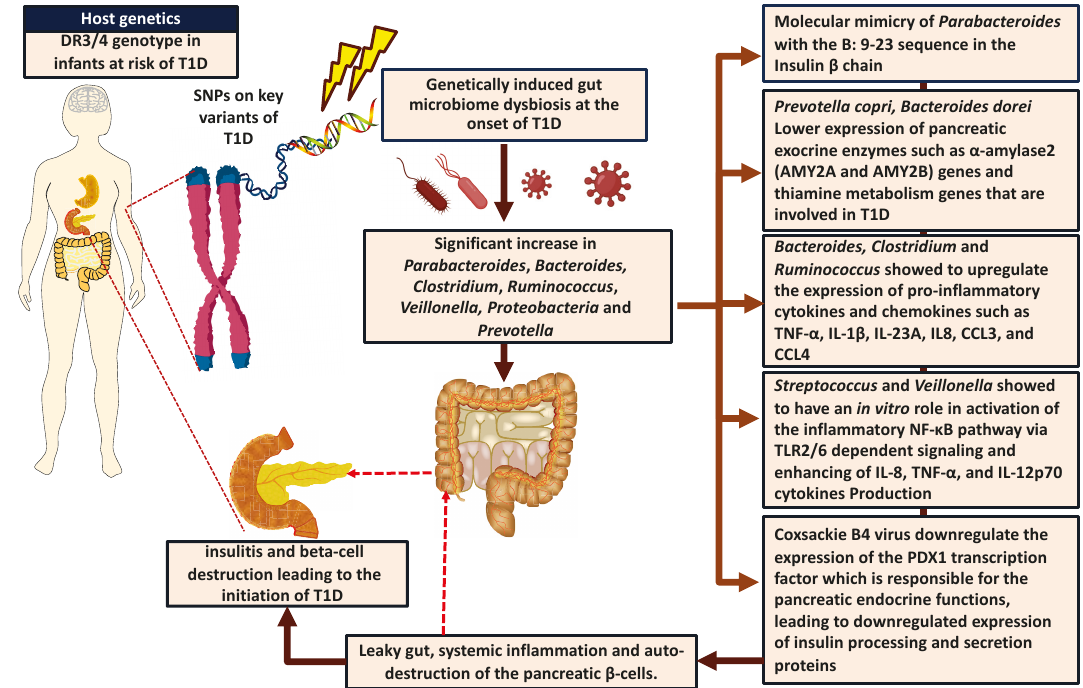
Figure 1. Interaction between host genetic, the gut microbiome in individuals with T1D. T1D is well known to be associated with microbial dysbiosis, a leaky gut, and intestinal inflammation. Changes in the gut microbial composition can enhance different pathological mechanisms in which each microbiome shows a different role, affecting the expression of the pancreatic exocrine enzymes such as α -amylase2 ( AMY2A and AMY2B ) genes as well as the thiamine metabolism genes known to be involved in T1D. The figure was created using BioRender.com and Science slides